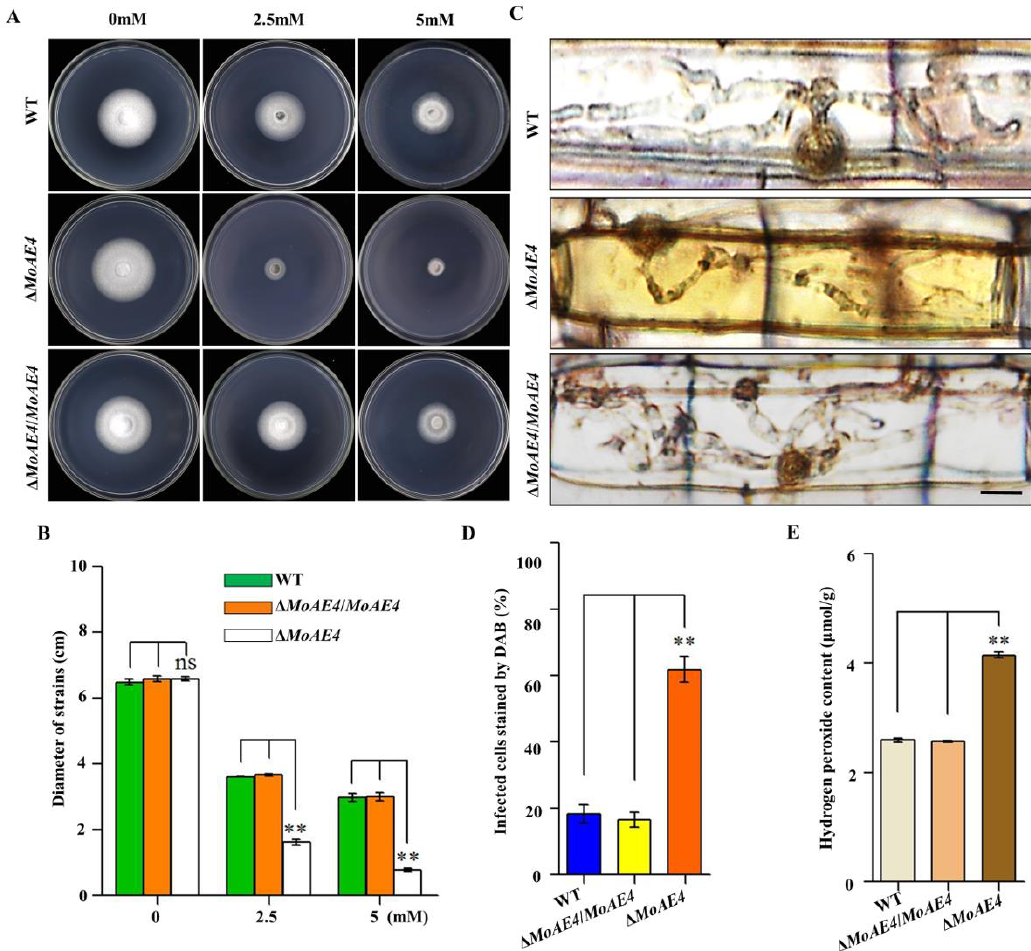
Figure 7. Comparison of oxidative stress, DAB staining, and endogenous H 2 O 2 among the wild type, the ∆ MoAE4 , and ∆ MoAE4 / MoAE4 strains. ( A ) H 2 O 2 stress assay. The strains were cultured in CM media for 7 days at 28 °C with 2.5 or 5 mM H 2 O 2 . ( B ) The colonies diameter of the wild type, Δ MoAE4 , and Δ MoAE4 / MoAE4 following treatment with 2.5 or 5 mM H 2 O 2 . ( C ) DAB staining of leaf sheath cells of rice infected by wild type, mutant and complementation strains at 36 hpi. Scale bar = 10 μm. ( D ) Statistical analysis of DAB staining of leaf sheath cells infected by different strains. ( E ) Endogenous H 2 O 2 assay. The strains of hyphae of Endogenous H 2 O 2 were determined as described in Experimental Procedures. The above experiments were performed in triplicate and repeated three independent times for each strain. Error bars represent the ± SD of three independently repeated samples, ns p > 0.05. ** p < 0.01.